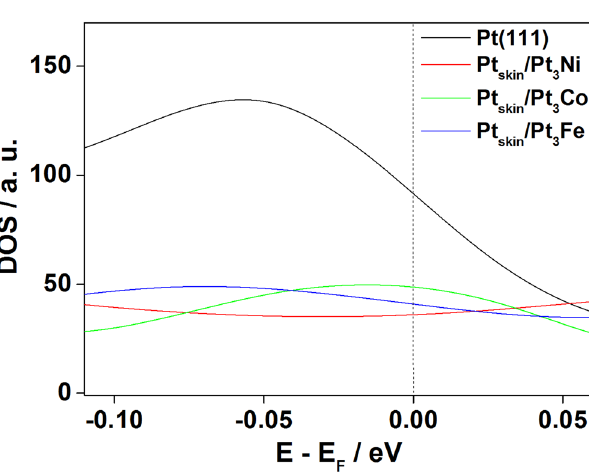
Figure 6. Phosphoric acid adsorption strength. δ E ad (differences in Δ E ad ) determined from the DFT calculation (y axis) as a function of accumulated charge density from 0.35 to 0.45 V in the electrochemical analysis.